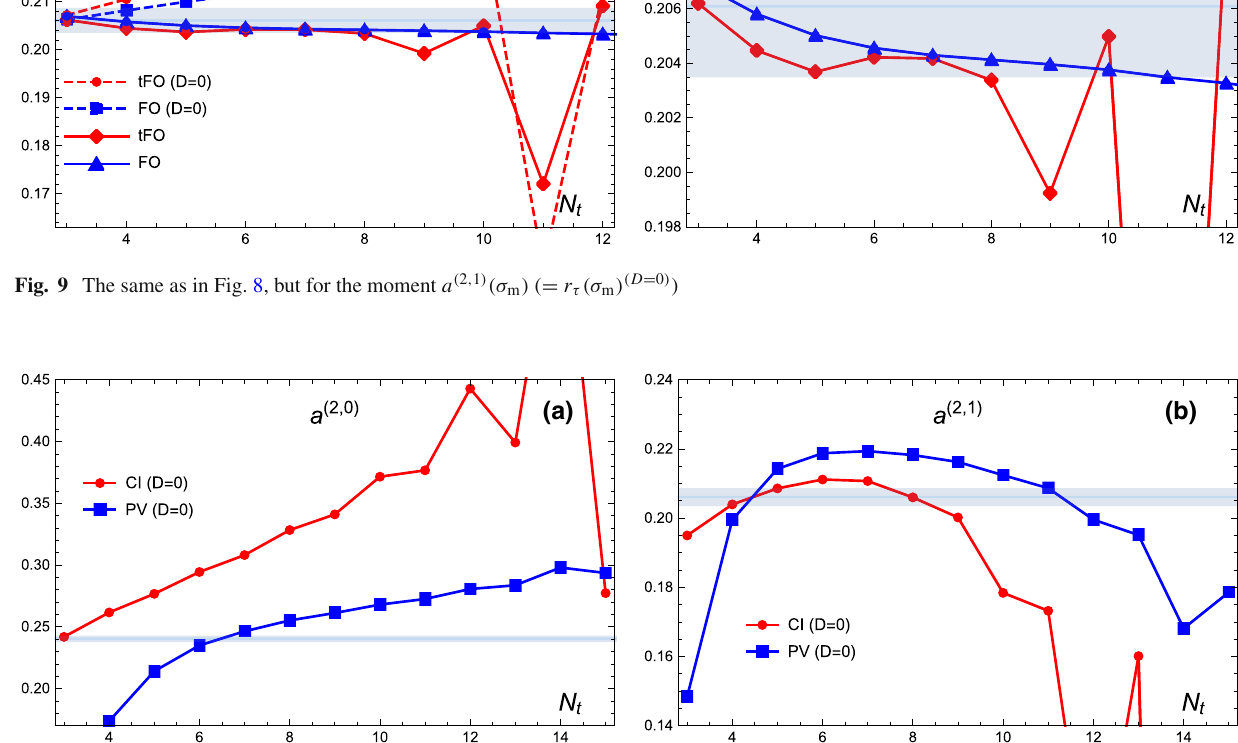
time, α s ( m 2 τ ) = 0 . 3349 and 0 . 3157 for CIPT and PV, respectively.